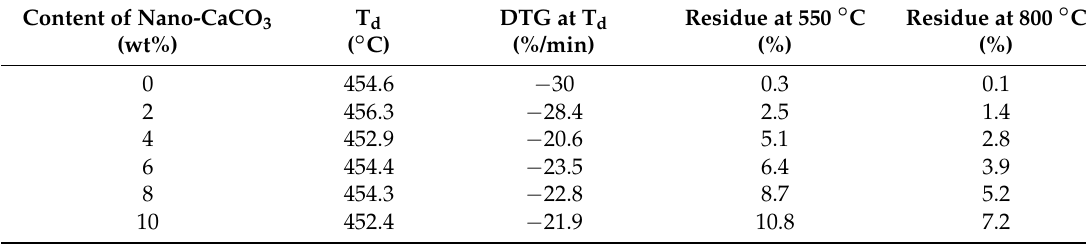
Table 2. Comparison of Thermogravimetric analysis (TGA) properties of nanocomposites. Content of Nano-CaCO